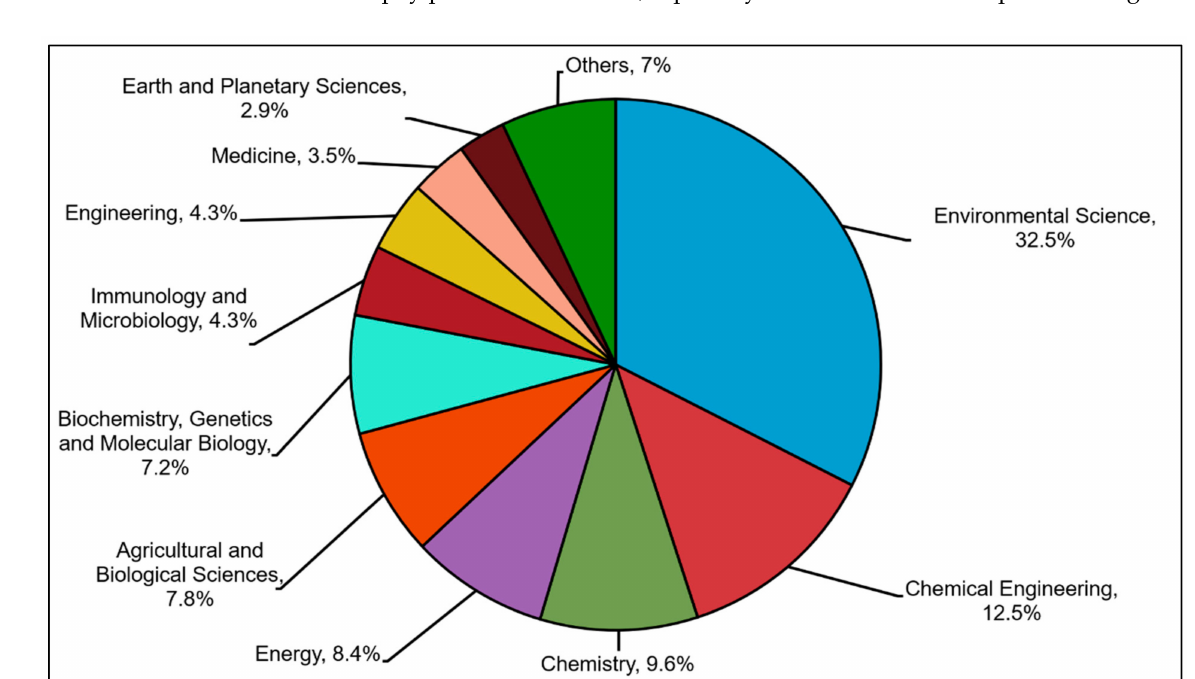
Figure 3. Distribution publication on subject